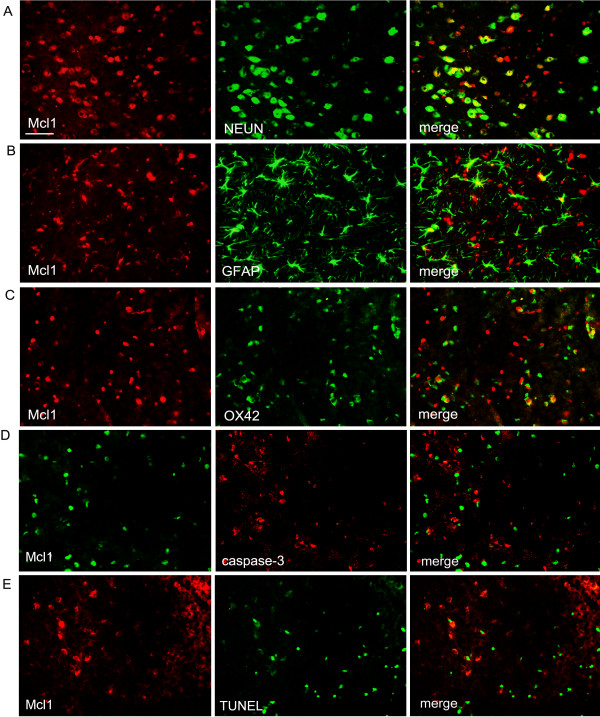
Cellular distribution of Mcl1 in rat brain after middle cerebral artery occlusion (MCAO). (A) Double immunostaining showed the overwhelming majority of Mcl1 co-localized with NEUN-positive neurons. By contrast, only a few Mcl1 positive cells were labeled with GFAP-positive astrocytes (B) or OX42-positive microglia/macrophages (C). (D-E) Double staining indicated that Mcl1 positive cells did not co-localize with caspase-3 or TUNEL positive cells in the ischemic brain, respectively. Cont: control group. Scale bars = 50 μm.